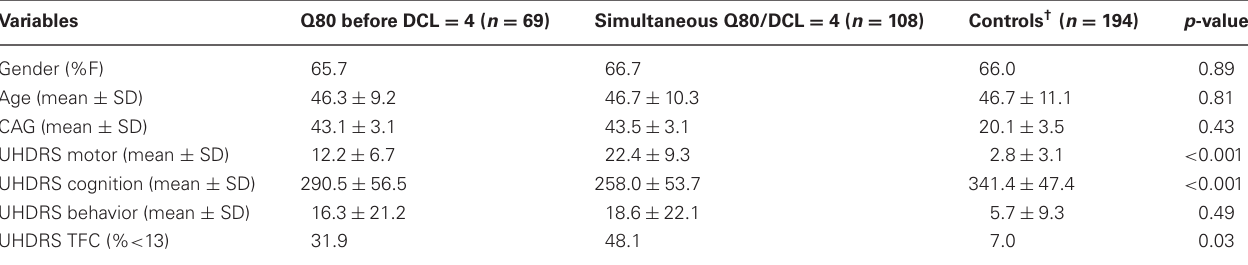
Table 3 | Clinical features at time of diagnosis.